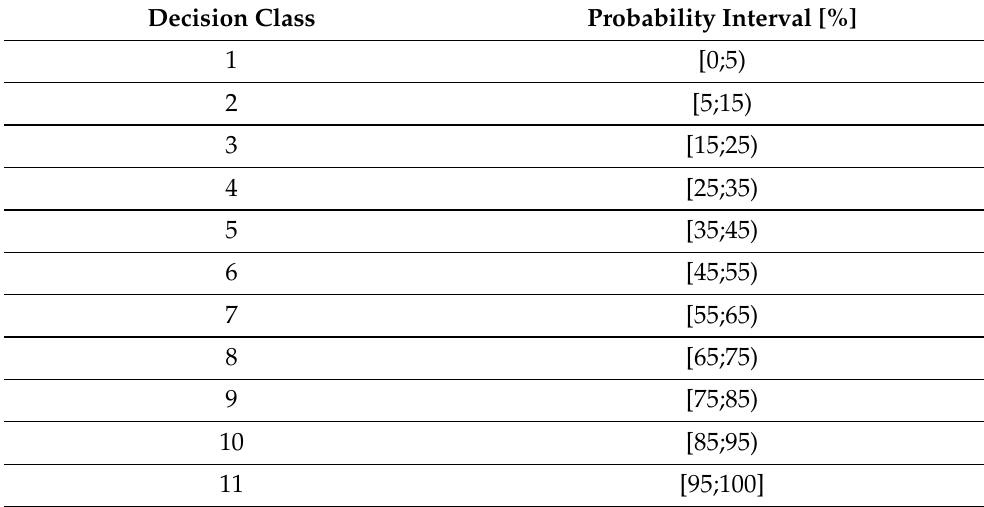
Table 2. Decision class labels representing ranges of probabilities of packet being